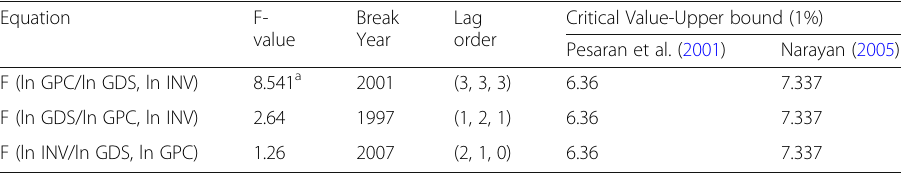
Table 5 Bound testing for existence of a level relationship Equation